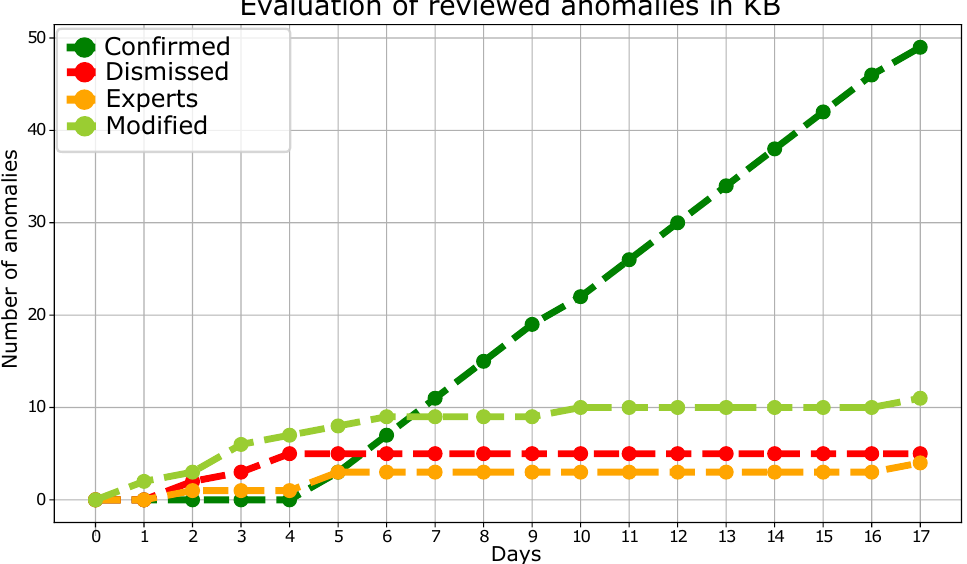
Figure 4. Evolution of the number of intervals of each case of anomaly.